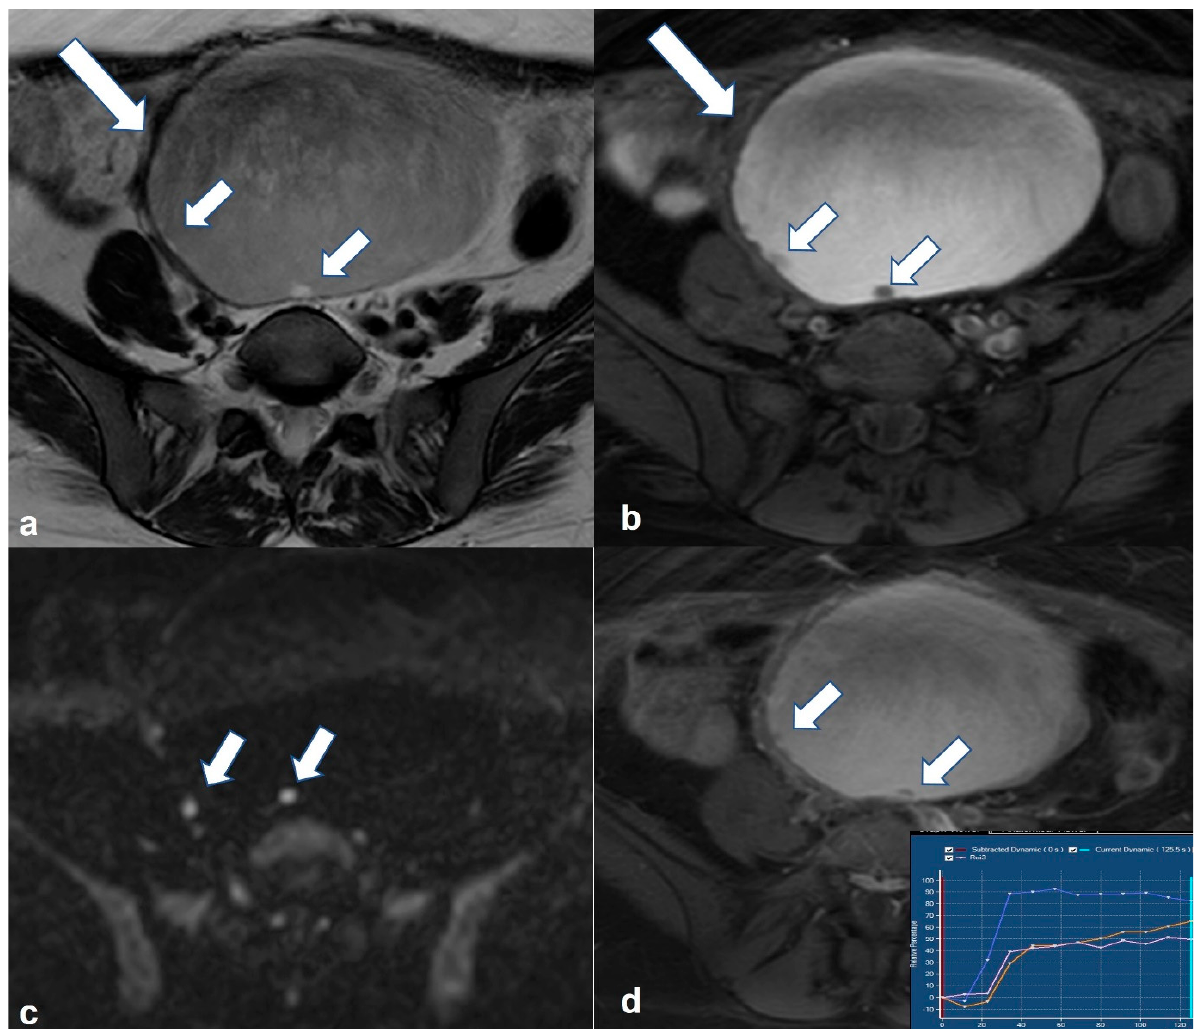
Figure 7. Endometrioid borderline ovarian tumor Axial T2 weighted image ( a ) shows a cystic mass (large arrow) originating from the right ovary with hemorrhagic content on corresponding axial T1 weighted FS image ( b ). There are small mural nodules in the right posterolateral aspect of the lesion (small arrows in a and ( b )) with restricted diffusivity on corresponding axial high b value DWI image (small arrows in ( c )). Note the enhancement of the nodules on the corresponding axial T1 weighted FS CE image (small arrows in ( d )). DCE analysis showed a type 2 time–intensity curve (inset in ( d ), blue line: uterus; yellow/pink line: nodules).